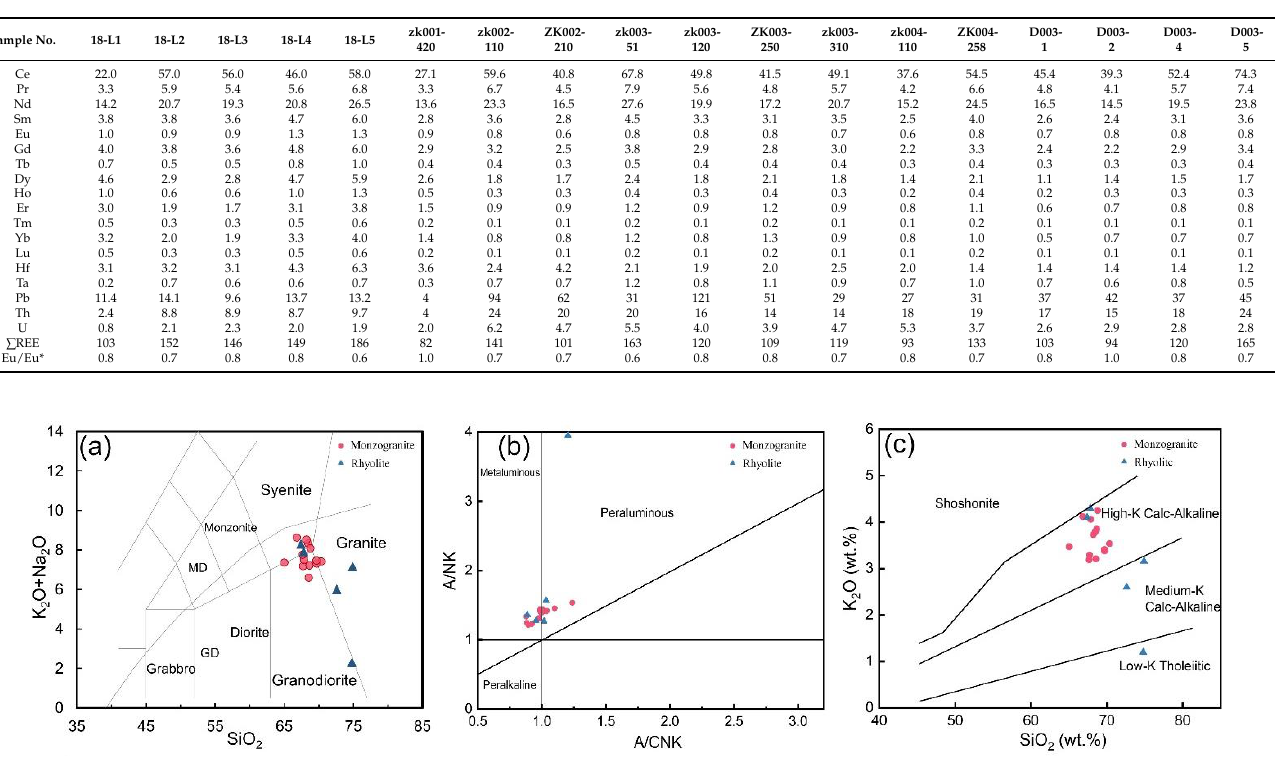
Figure 4. Geochemical features of the Demingding granitoid. ( a ) Diagrams of K 2 O + Na 2 O versus SiO 2 , ( b ) A/CNK versus A/NK diagram, ( c ) SiO 2 versus K 2 O plot. Abbreviations: MD –– Monzo-dio-